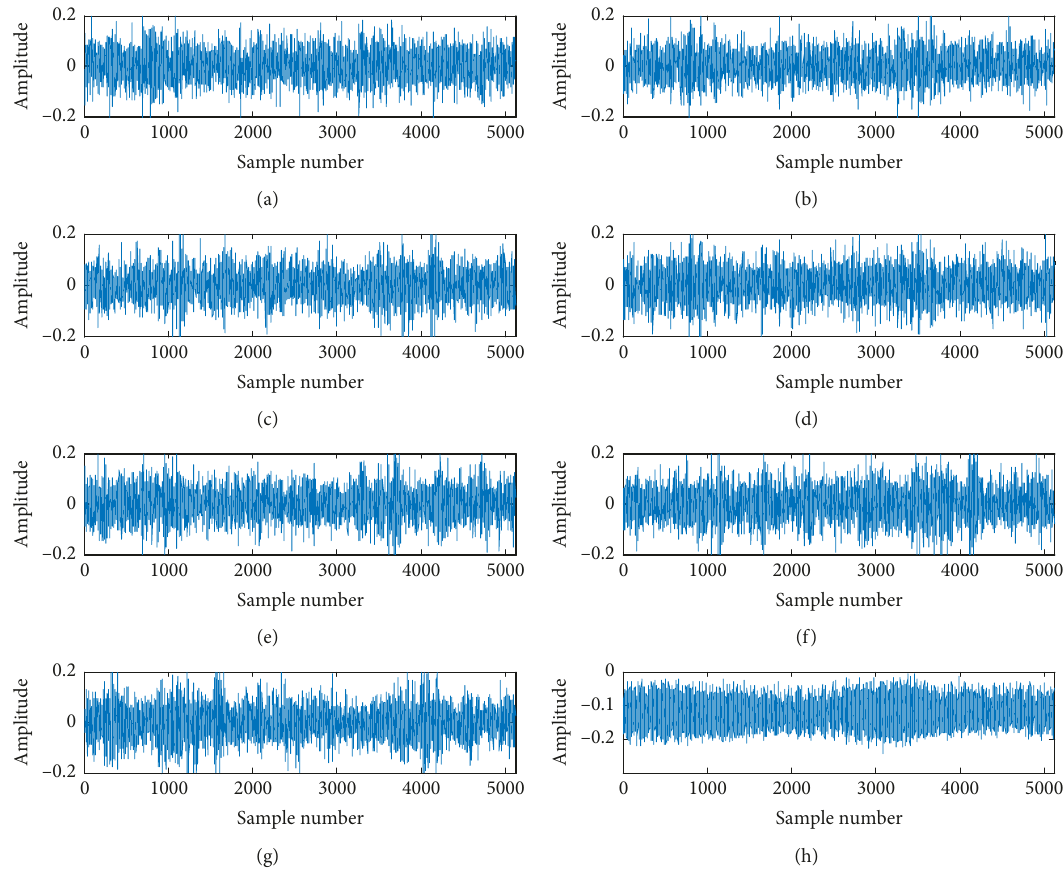
, X , X , X , X , 44DMD 45DMD 41DMD 42DMD 43DMD